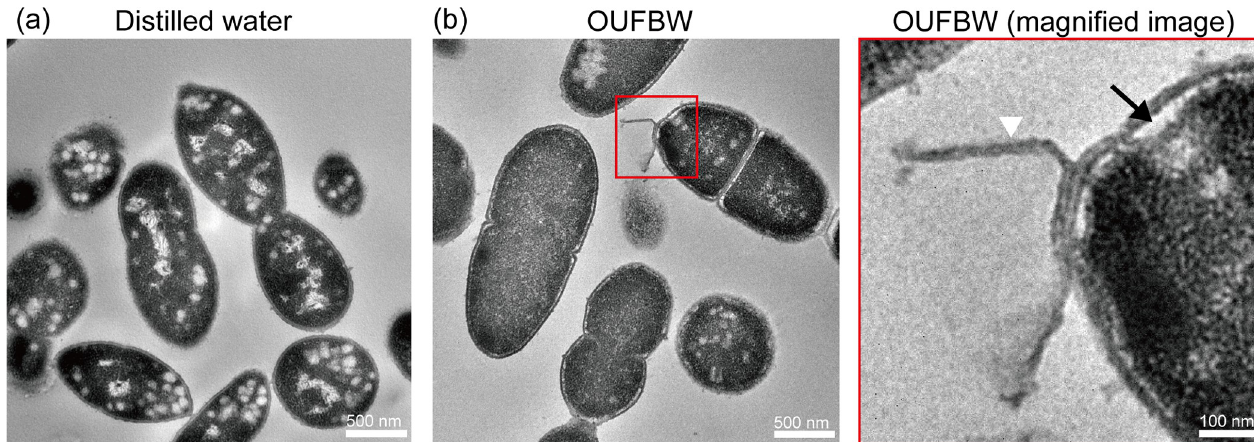
Fig 3. Transmission electron microscope observation of S . pneumoniae exposed to ozone ultrafine bubble water (OUFBW). Representative transmission electron micrographs of macrolide-resistant S . pneumoniae NU4471 after exposure to (a) distilled water or (b) 1 ppm OUFBW. The black arrow indicates the crevice between cell wall and cytoplasm, and the white arrow head indicates the cell wall debris.